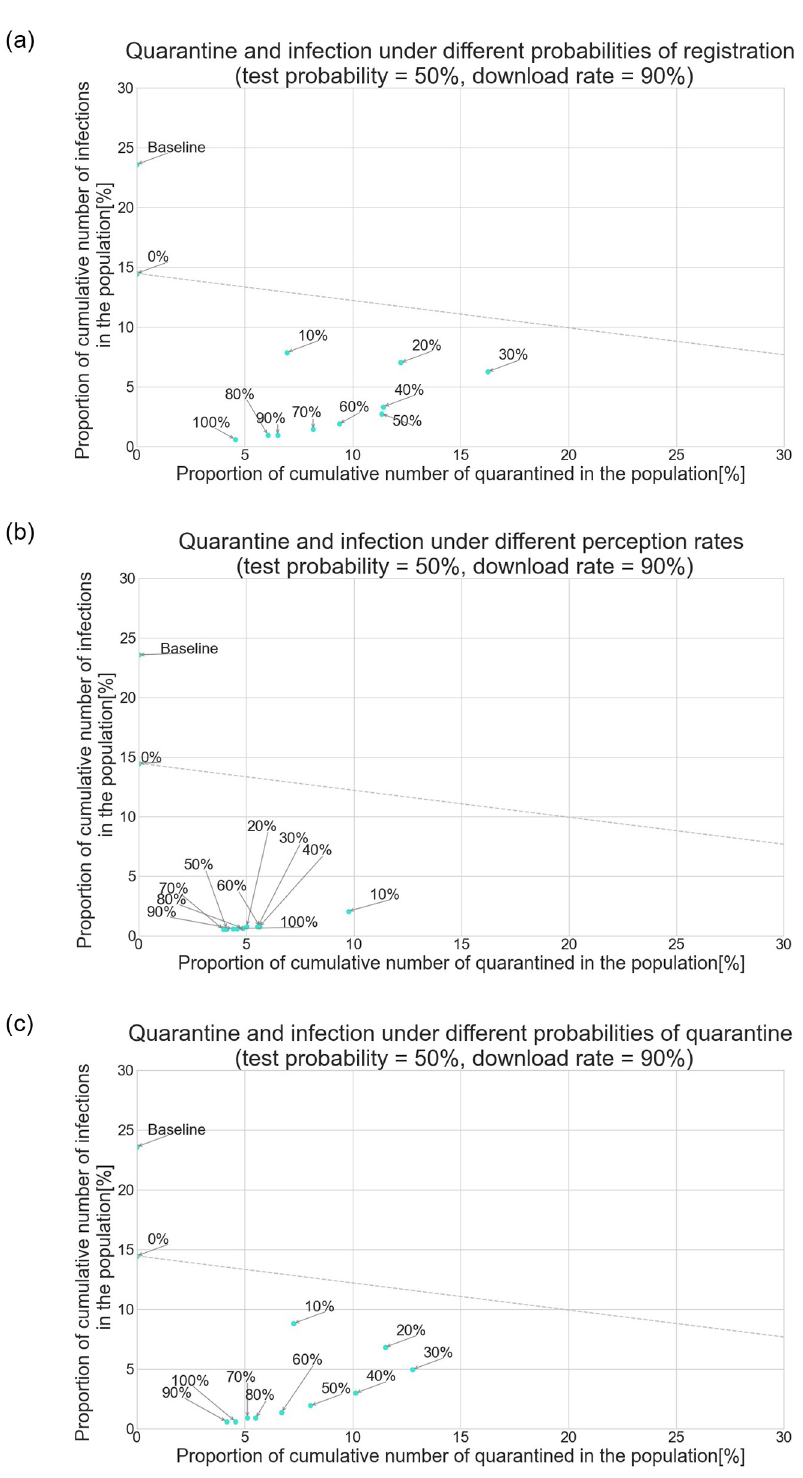
Fig 6. Scenarios of imperfect registration of test results, perception rate, and quarantine. (a) Scenario of varied probability of registration. (b) Scenario of varied perception rate. (c) Scenario of varied probability of quarantine.